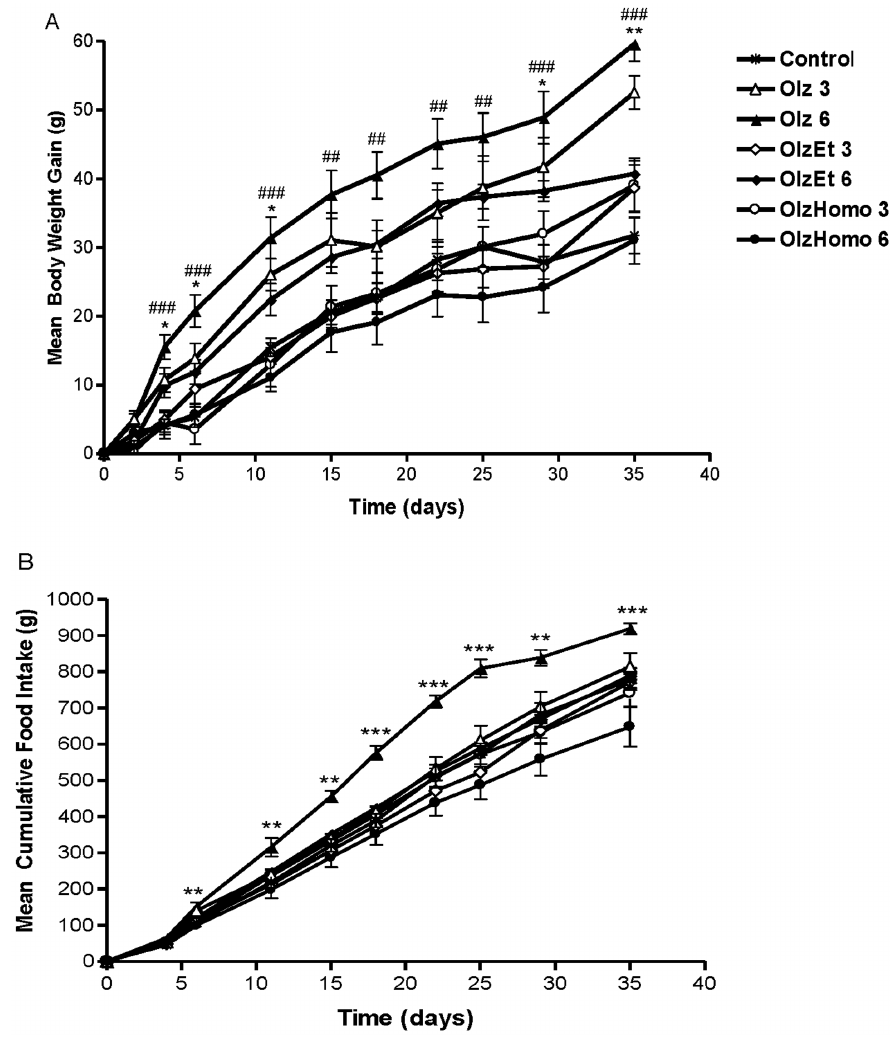
Figure 2. Cumulative weight gain and food intake in female rats treated with Olz and Olz derivatives. A. Cumulative body weight gain (g), B. Cumulative food intake (g) in female Sprague Dawley rats treated with Olz, OlzEt, OlzHomo (3 mg/kg or 6 mg/kg), or vehicle (Control) for 5 weeks. The data points are the mean 6 SEM. A. * P , 0.05, ** P , 0.01: Olz 3 mg/kg vs. control. ## P , 0.01, ### P , 0.001: Olz 6 mg/kg vs . Control. B. N ** P , 0.01, *** P , 0.001: Olz 6 mg/kg vs . Control. (*: Control, D : Olz 3 mg/kg, m : 6 mg/kg, e : OlzEt 3 mg/kg, ¤ : OlzEt 6 mg/kg, o: OlzHomo 3 mg/kg : OlzHomo 6 mg/kg). and